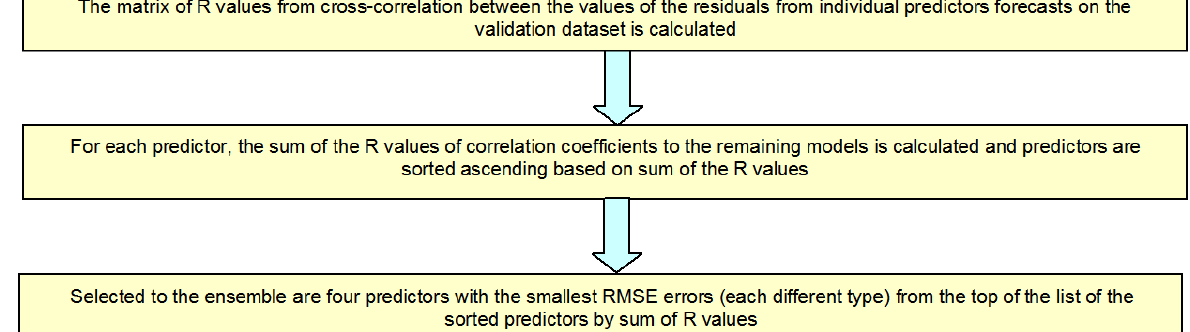
as the integrator of the ensemble: MLP, KNN, random forest (RF) and linear regression (LR). Each ML integrator uses forecasts of power demand from four individual predictors as input data and the real values of power demand as the output. A training dataset is used for training ML integrator, and a validation dataset is used for RMSE control and tuning of hyperparameters. Finally, the evaluation criteria are verified against the test da- taset. The general structure of four machine learning methods as an integrator of ensemble is presented in Figure 11 [49,64].